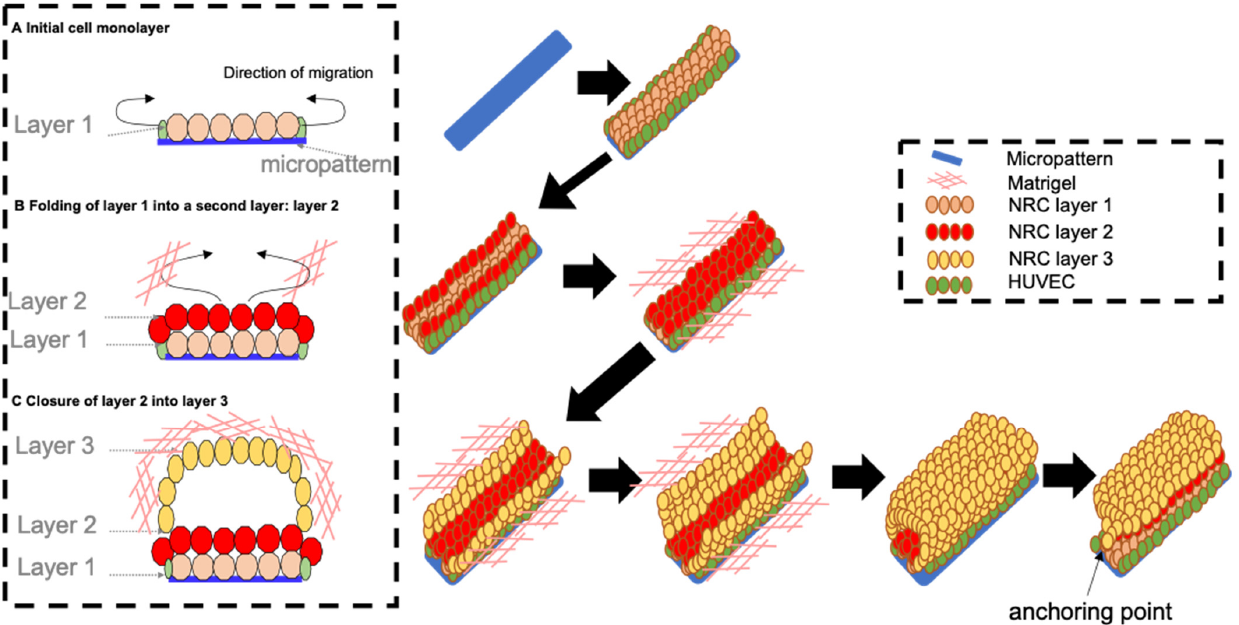
Figure 7. Model for tube formation from micropatterns. ( A ) initial cell adhesion of NRC cells with HUVEC cells on the micropattern. ( B ) folding step of layer 1 into a second layer: layer 2. ( C ) luminogenesis step finishing the self-organization process with the closure of layer 2 into a third layer: layer 3.